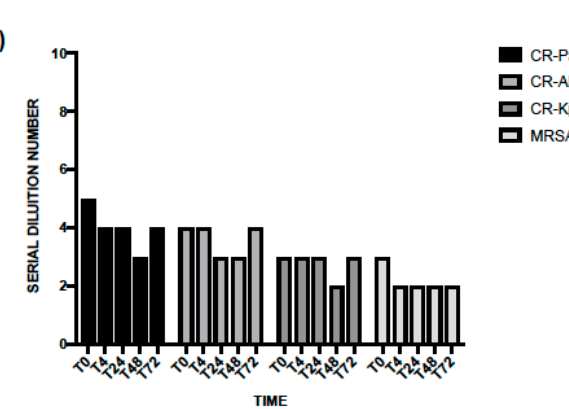
Figure 3. Antibacterial activity of probiotic whole compound (WP, A ) and probiotic cell-free surnatant (PS, B ) against clinical strains of carbapenem-resistant (CR) P. aeruginosa (Pa), CR A. baumannii (Ab), CR K. pneumoniae (Kp), and methicillin-resistant S. aureus (MRSA) at different incubation times. The serial dilution number (y axis) corresponds to the number of the serial WP and PS dilutions needed to obtain the corresponding minimal bactericidal dilution (MBD). Results were expressed as mean. Standard deviation (SD) is not graphically represented since the values of the experiments (performed in duplicate) were the same.